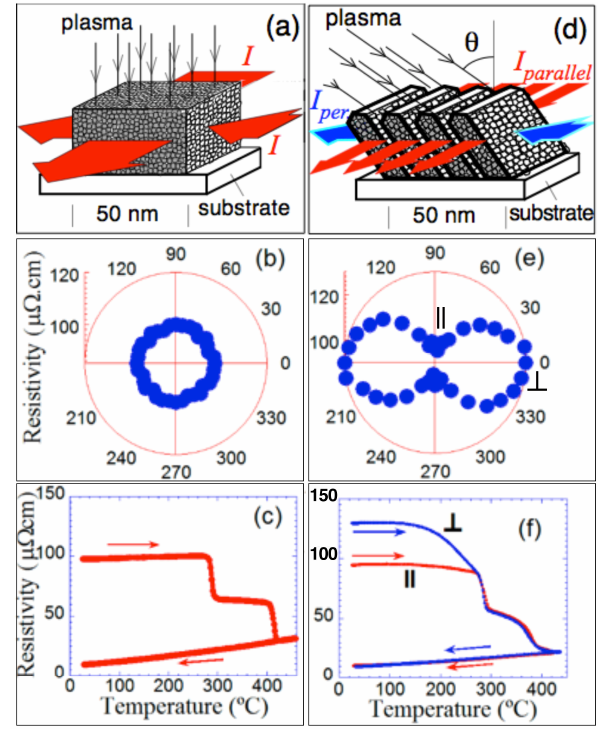
Figure 2. Scheme of the film with nano-crystals of 1 to 2 nm: ( a ) normally deposited; ( b ) polar plot of its resistivity at room temperature; ( c ) temperature dependence of its resistivity. Scheme also with nano-crystals of 1 to 2 nm: ( d ) corresponding to the Co film formed by nano-sheets; ( e ) polar plot of its resistivity at room temperature; and ( f ) temperature dependence of its resistivity. The zero angle value at the polar plots corresponds to the perpendicular to nano-sheets direction.